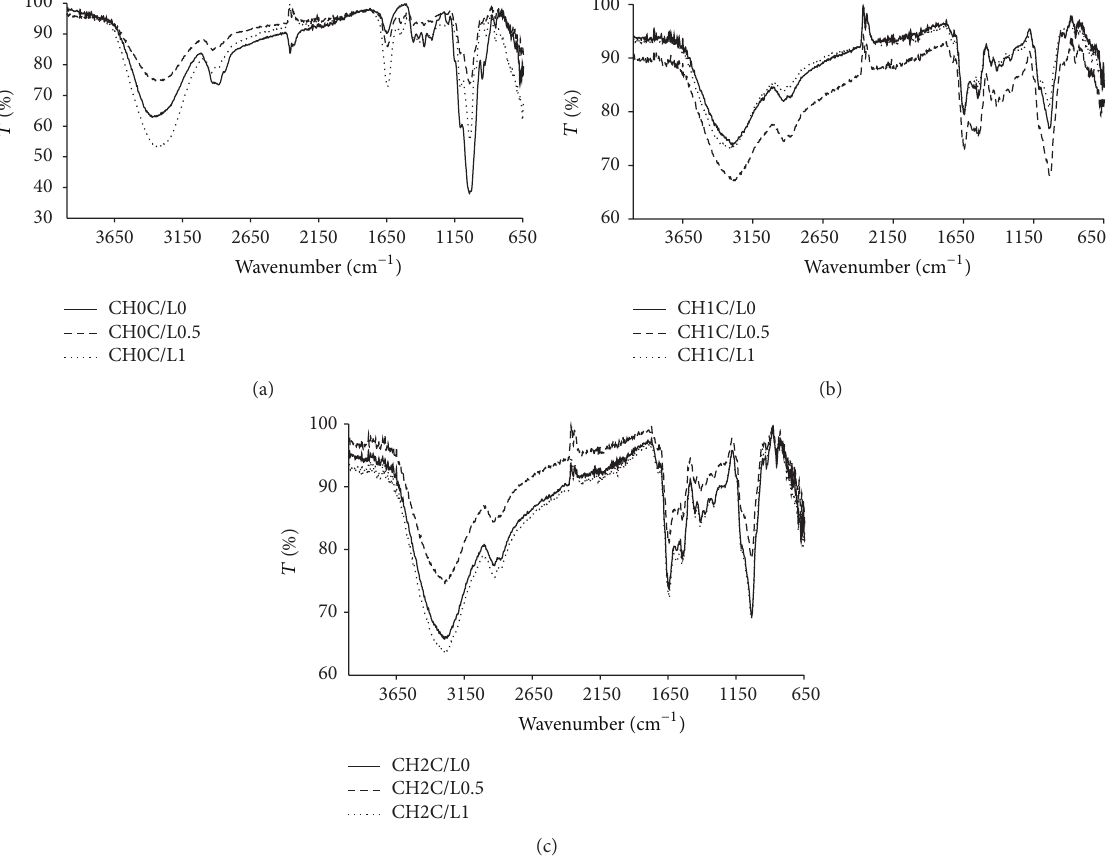
Figure 3: FTIR spectra of HMPC and C/L preparation films of (a) CH0C/L0, CH0C/L0.5, and CH0C/L1; (b) CH1C/L0, CH1C/L0.5, and CH1C/L1; and (c) CH2C/L0, CH2C/L0.5, and CH2C/L1 variants. Table 3: Antibacterial activity of edible films modified by CH and C/L preparation (main effects). Main